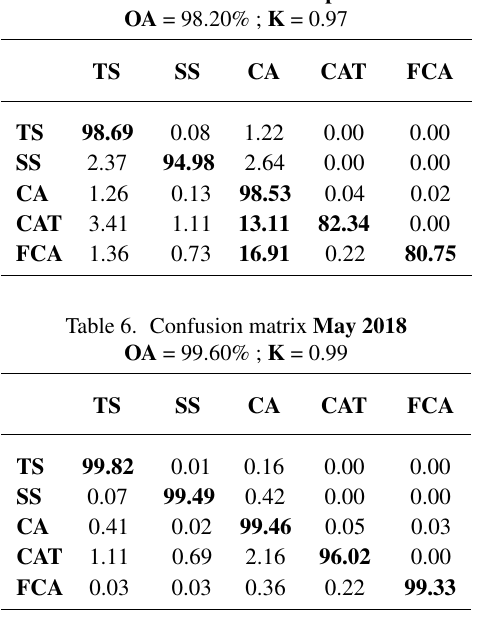
Table 7. Confusion matrix June 2018